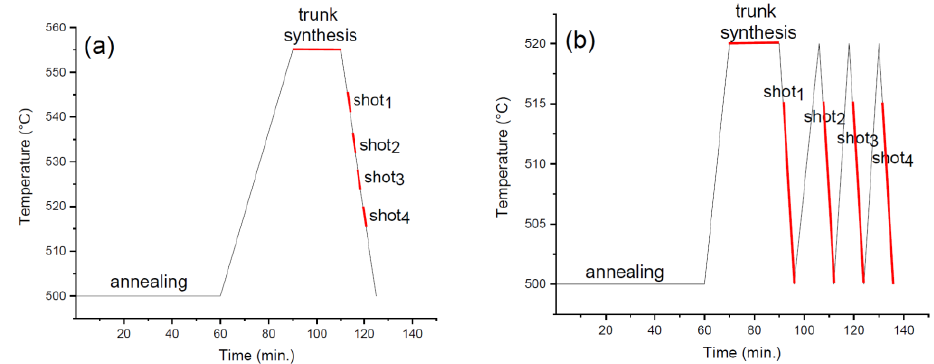
Figure 1. Scheme of silicon nanotrees synthesis steps synthesized by low-pressure chemical vapor deposition: ( a ) Four Silane shots in one temperature drop, ( b ) Four cycles with one Silane shot per cycle.